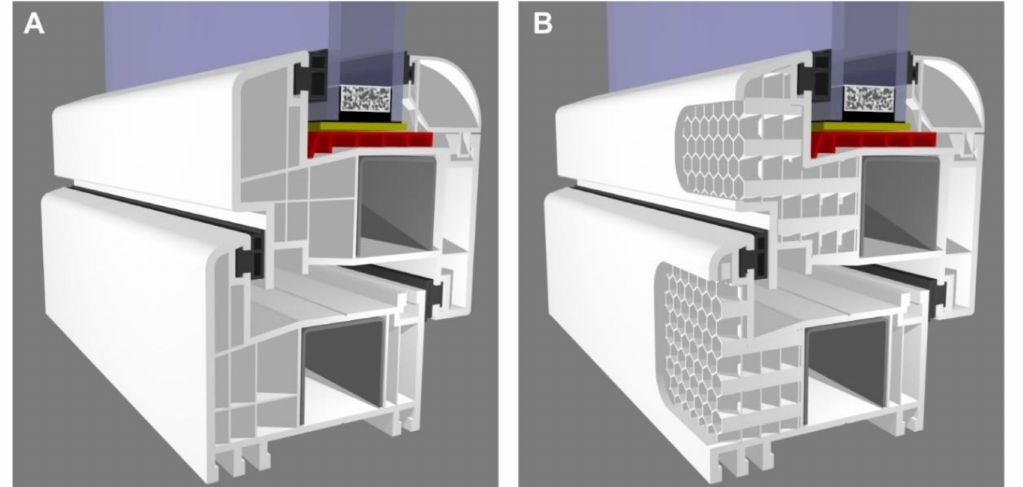
Figure 1. Cross-section of a plastic window frame: ( A ) typical, ( B ) external parts filled with the 3D printed exemplary structure considered by the